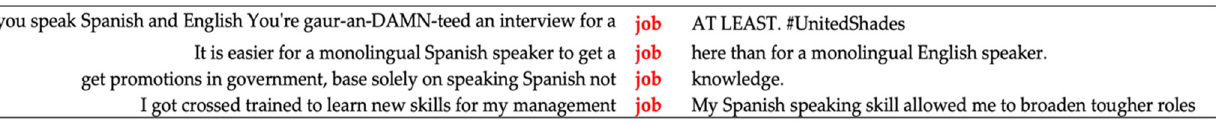
Figure 3. Concordance lines for job that indicate negative attitudes on the status dimension.